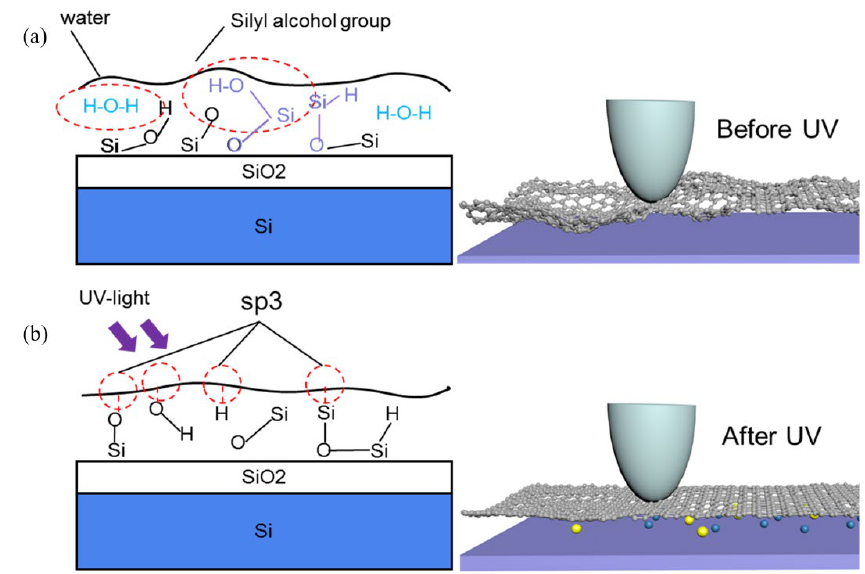
Figure 7. ( a ) Schematic diagram of hanging bond changes between graphene and substrate before and after UV irradiation. ( b ) Schematic diagram of friction after UV vacuum treatment of graphene. The hydration electron: the REDOX potential is − 2.9 V, and ϕ represents the quantum yield of each reaction